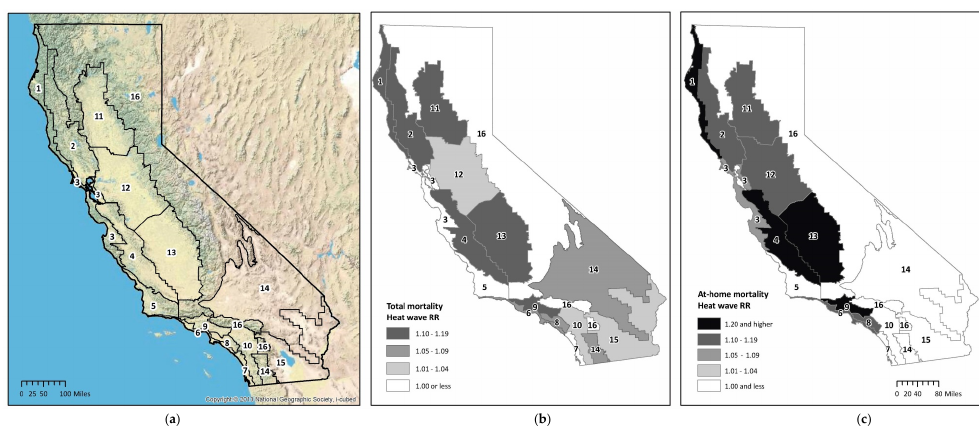
Figure 2. Heat wave total and at-home all-cause mortality relative risks (RRs) for California’s sixteen building climate zones: ( a ) California’s sixteen building climate zones and topography; ( b ) Total mortality heat wave relative risk by building climate zone; ( c ) At-home mortality heat wave relative risk by building climate zone.